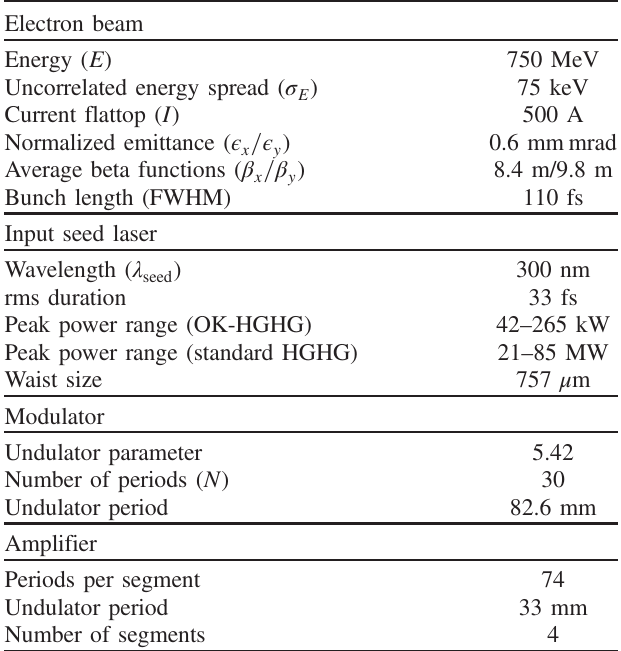
TABLE I. Simulation parameters of the nominal case and for the harmonics between the 8th and 15th harmonic of a 300 nm seed laser wavelength. The seed laser peak power range refers to harmonics between the 8th and 15th. In some simulations, the temporal dependence is not used.